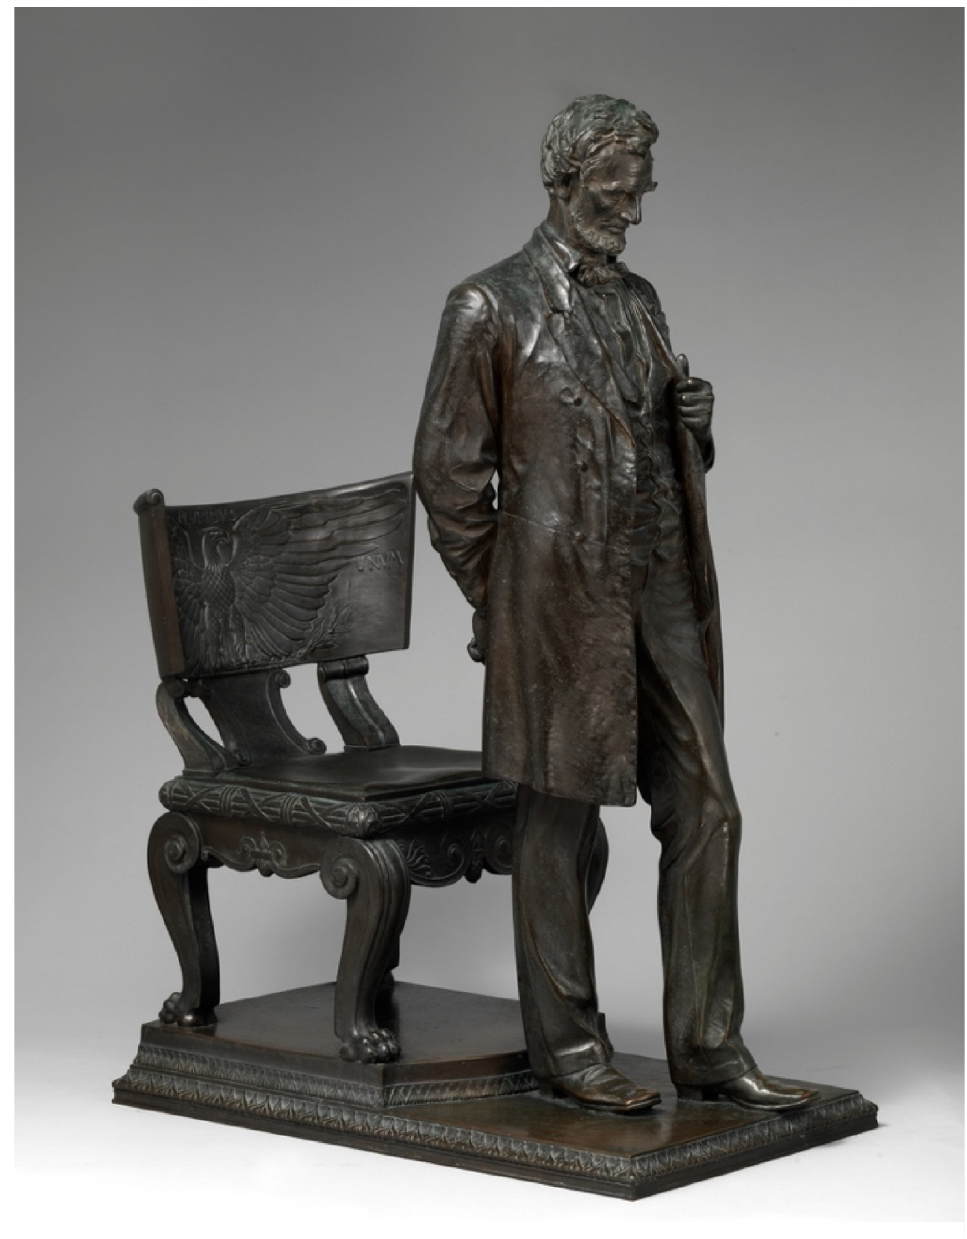
Figure 3 Augustus Saint-Gaudens (American, born Ireland, 1848–1907), Abraham Lincoln: The Man